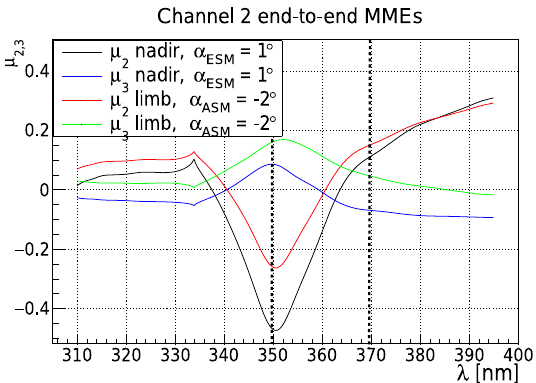
Figure 7. Polarized end-to-end MMEs ( µ 2 , 3 ) for nadir (black: µ 2 ; blue: µ 3 ) and limb (red: µ 2 ; green: µ 3 ) calculated with the scan mirror model for August 2002. The MMEs are given in the atmo- spheric Stokes frame. The thick dashed vertical lines indicate the two spectral points used to build the polarization signal (see